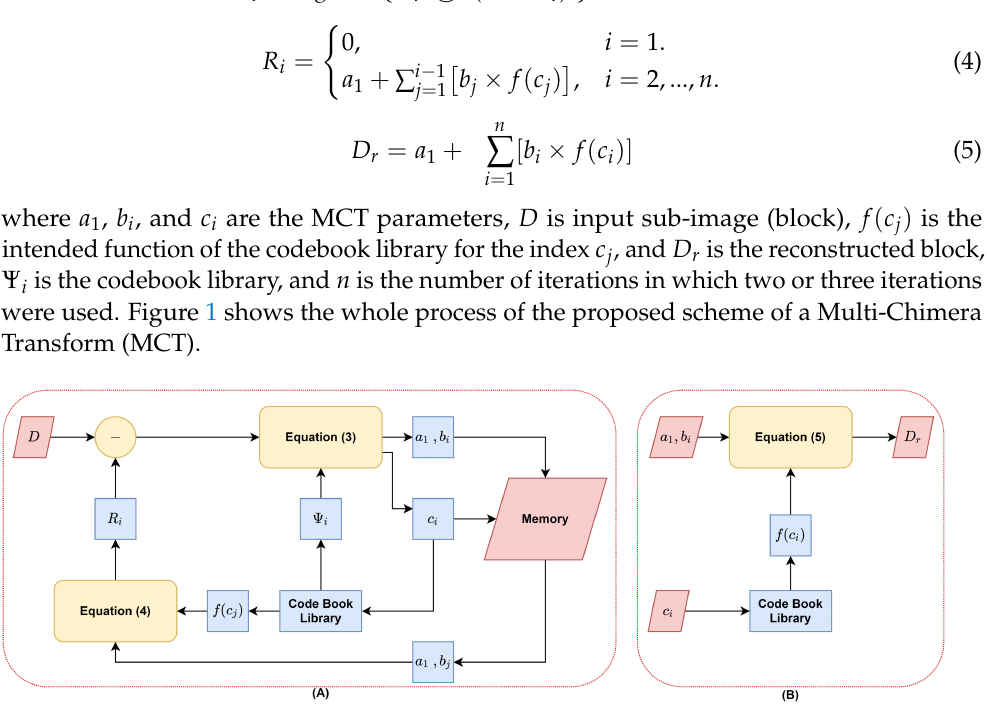
Figure 1. The block diagram of the proposed Multi-Chimera Transform (MCT). ( A ) Coding process and ( B ) Decoding